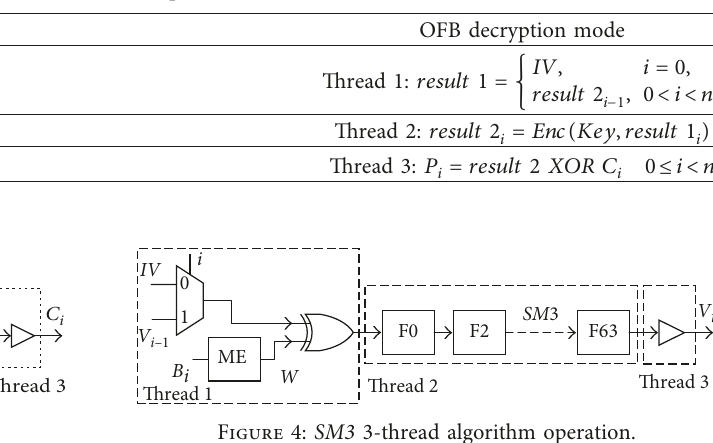
Table 1: Thread split.